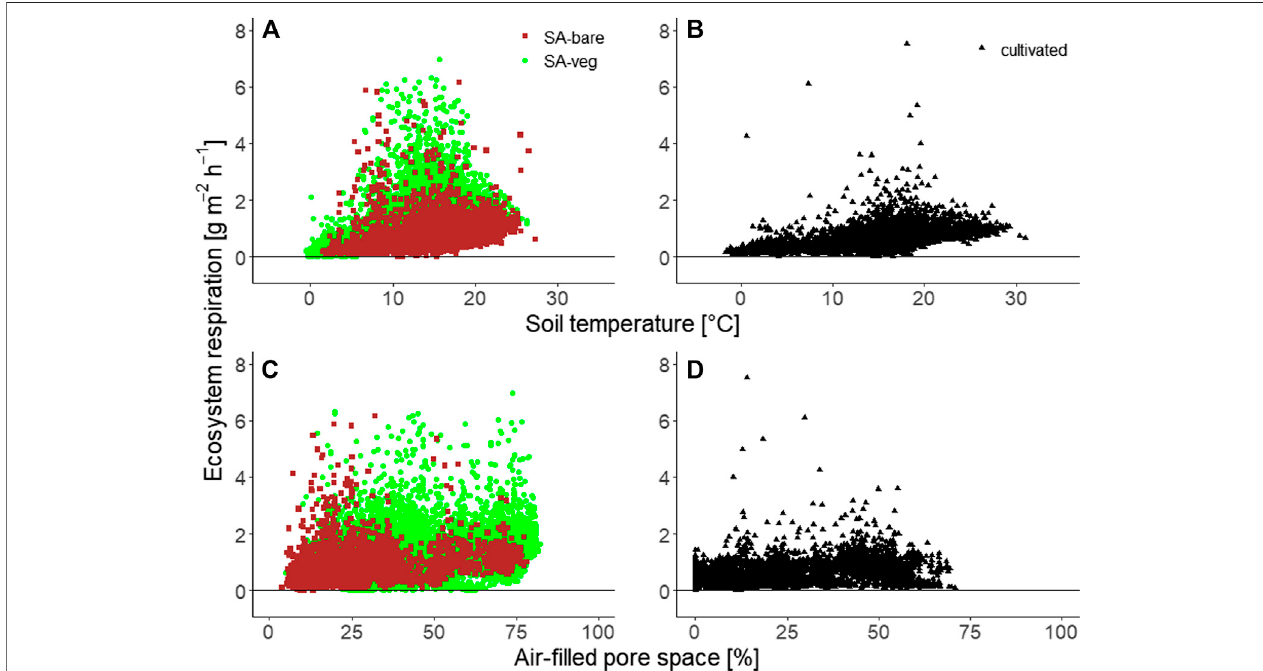
FIGURE 7 | Ecosystem respiration [g m − 2 h − 1 ] measured by automatic chambers at (A,C) the set-aside site and (B,D) the cultivated site, as a function of (A,B) soil temperature at 5 cm depth and (C,D) air- fi lled pore space.